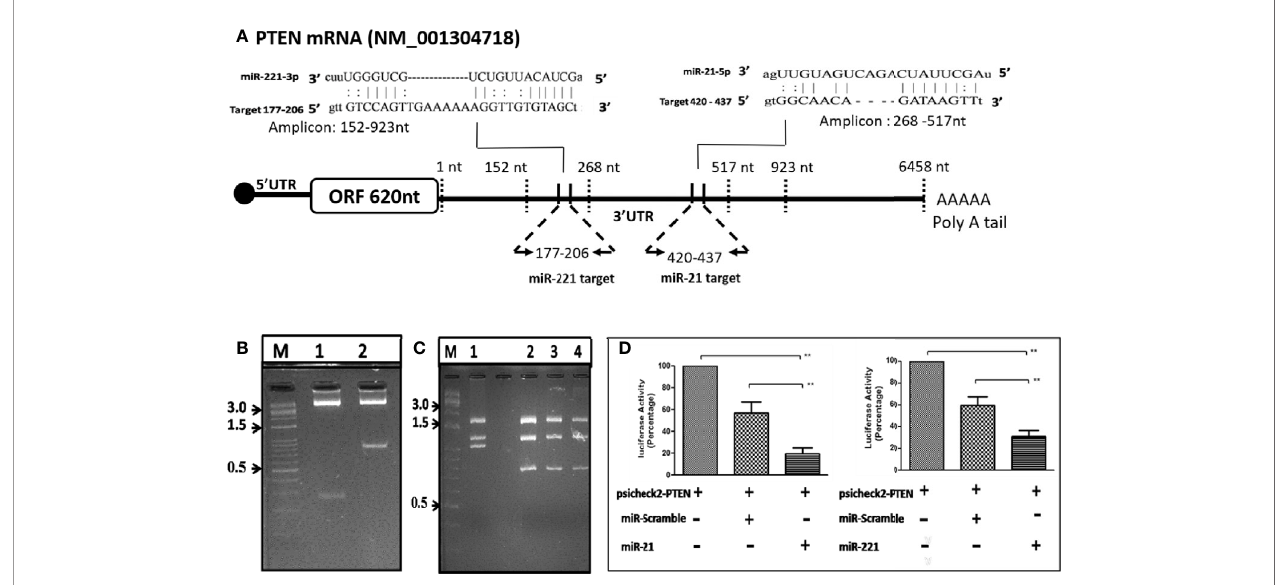
FIGURE 6 | OncomiR target validation by Luciferase reporter 3 ’ -UTR assay. (A) Schematic depiction of PTEN UTR as miR-21 and -221 targets through bioinformatic analysis. (B) Direction cloning of PTEN 3 ’ -UTR in psiCheck-2 vector as target for miR-21 (Lane 1) and miR-221 (Lane 2) and con fi rmed by double digestion with XhoI/NotI. (C) Cloning of short hairpin miR precursor in psiRNA-h7SKGFPzeo vector at BbsI. Positive clones are con fi rmed by digestion with SpeI (Lanes 1, no insert; 2, miR 21; 3, miR-221; 4, miR-Scr). (D) Luciferase reporter 3 ’ -UTR assay for target validation of miR-21 and miR-221. **P ≤